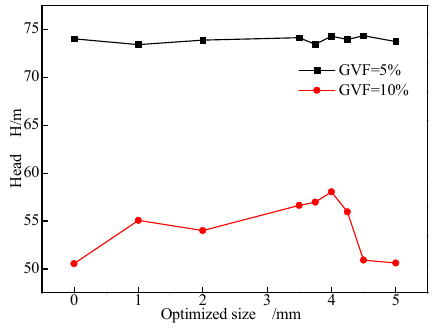
Figure 7. Head curve of different optimized sizes.